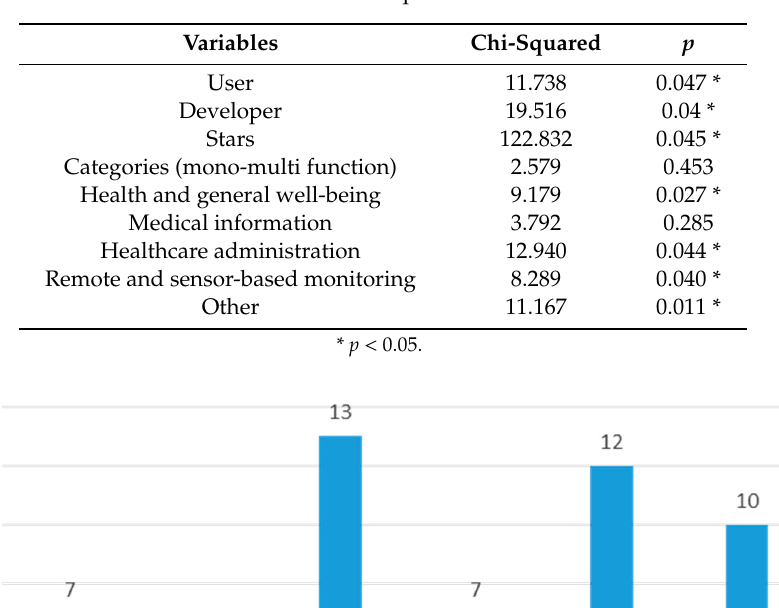
Table 3. Chi-square tests.